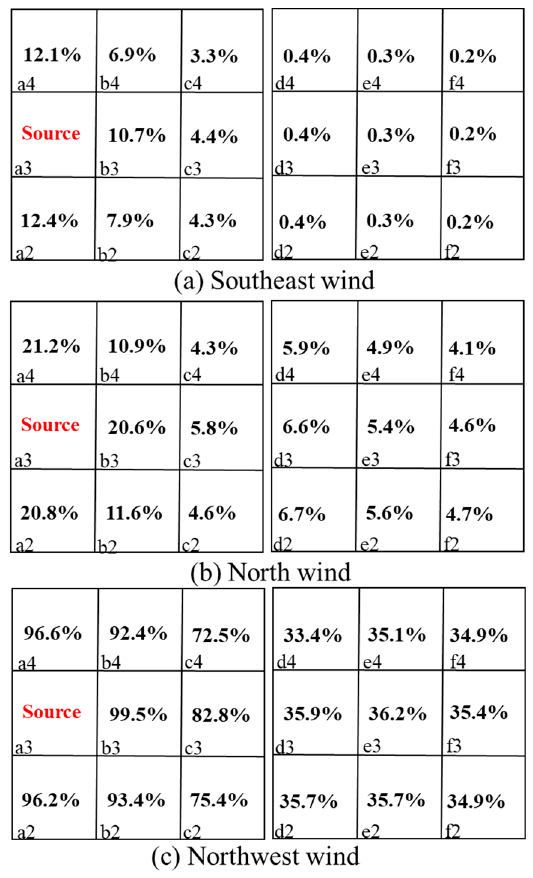
Figure 16. Interunit infectious risk p values of D3 with room a3 as the source under three wind directions. a1,2,3,4-e1,2,3,4 represent the number of dormitory room.